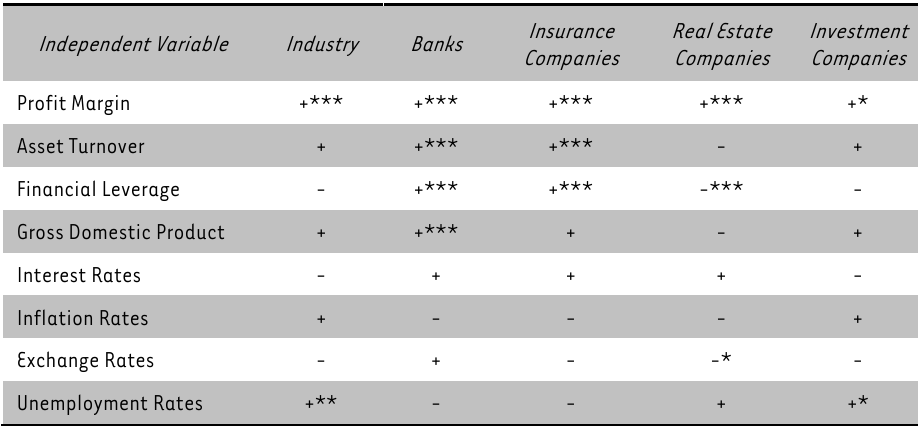
TABLE 6: Observed relationship between independent variables and ROE - APT Observed relationship between Independent Variables and Return on Equity